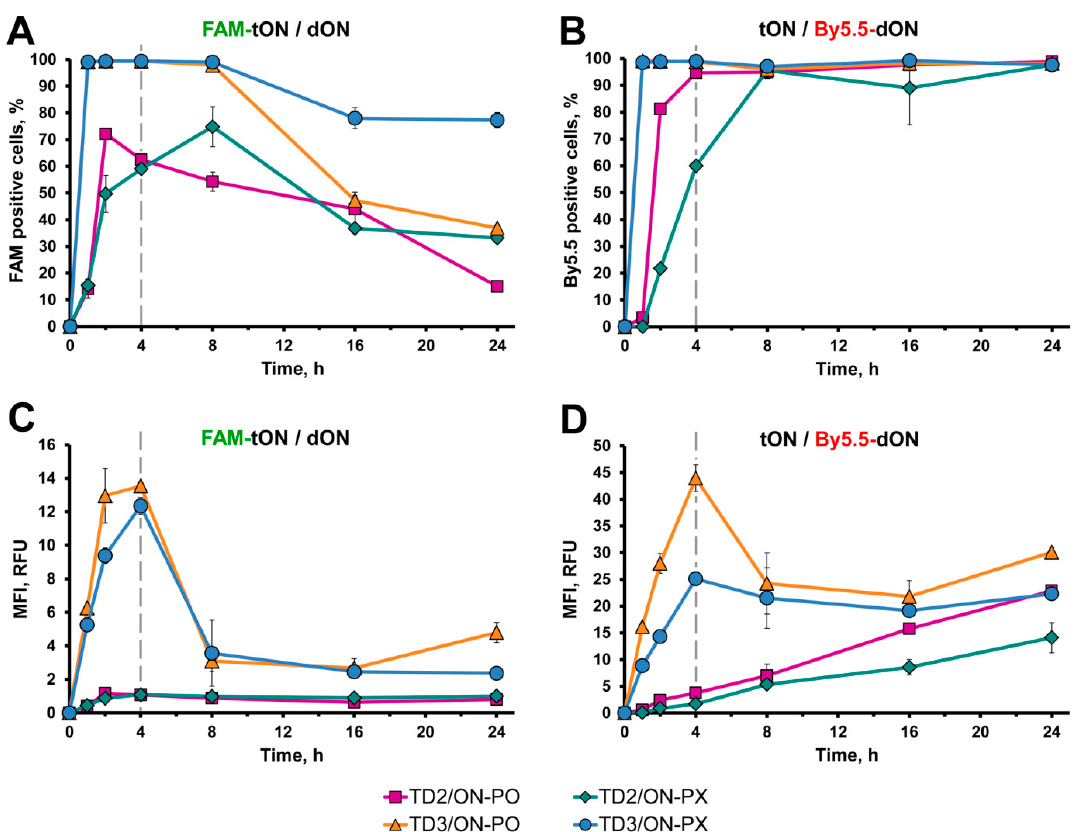
Figure 7. Kinetics of duplex accumulation into KB-8-5 cells. Analysis of samples was performed 1, 2, 4, 8, 16 and 24 h after addition of duplexes to the cells. Duplexes consisting of FAM-tON (TD3 or TD2) and By5.5-dON (ON-PO or ON-PX) were added to the cells at a final concentration of 1 µM. ( A ) The percentage of FAM-tON-positive cells. ( B ) The percentage of By5.5-dON-positive cells. ( C ) The mean fluorescence intensity of FAM-tON-positive cells. ( D ) The mean fluorescence intensity of By5.5-dON-positive cells. Duplexes TD2 / ON-PO = magenta line with squares; TD2 / ON-PX = green line with diamonds; TD3 / ON-PO = orange line with triangles; TD3 / ON-PX = blue line with circles. Dashed grey line = time point where FBS were added to the cells. Data presented as MEAN ± SD.